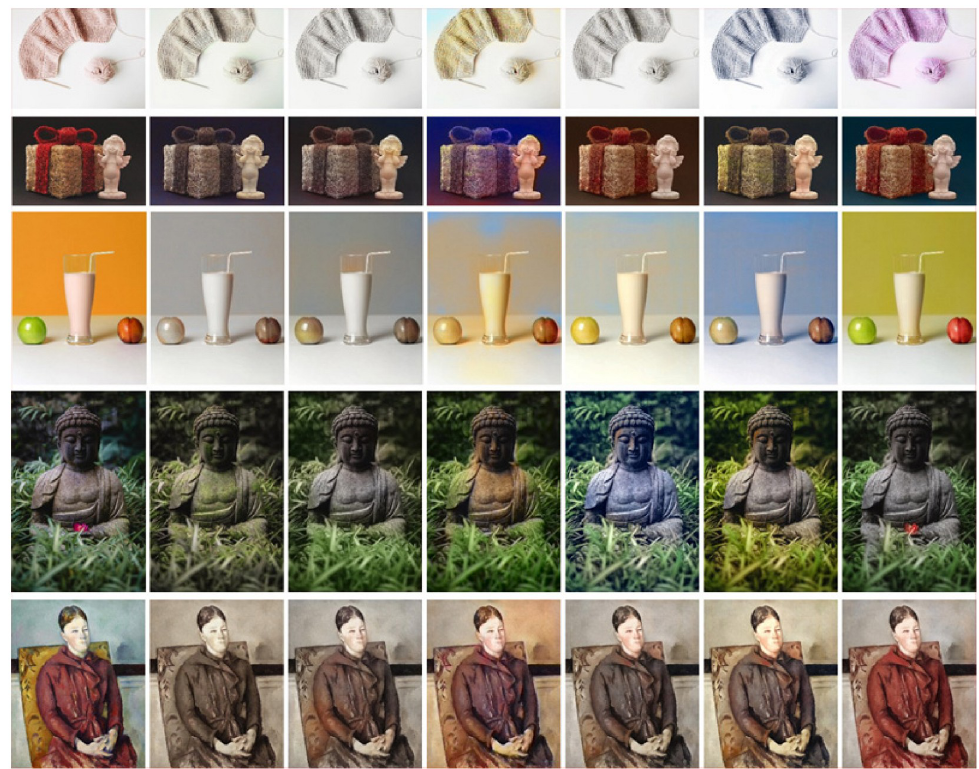
Fig 10. Transferability test of our algorithm. These five groups of images show the comparison of coloring effects of six algorithms on different materials, including wool, forging tape, ceramic, glass, stone Buddha, oil painting, etc. (a) GT, (b) [16], (c) [17], (d) [18], (e) [47], (f) [48], (g) Ours.